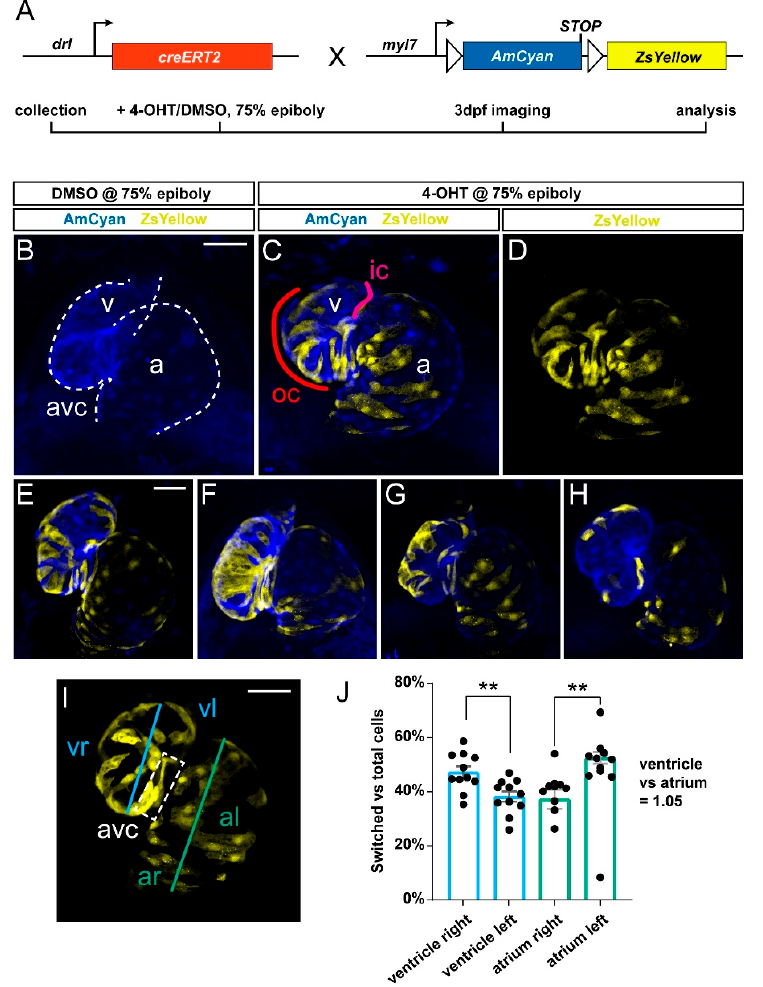
Figure 1. Predominant labeling of the first heart field (FHF)-assigned embryonic myocardium using drl:creERT2 . ( A ) Crossing scheme of used transgenes. drl:creERT2 is expressed in the gastrulation-stage lateral plate mesoderm (LPM) progenitors and becomes gradually restricted to FHF descendants in the heart, while myl7:Switch is a cardiomyocyte-specific loxP reporter line that by default marks myocardium in AmCyan (blue) and ZsYellow (yellow) upon exposure to active Cre recombinase. Timeframe of involved experimental steps outlined below. See text for details. ( B – H ) Maximum intensity projections of confocal stacks taken from three dpf zebrafish embryos double-transgenic for dr:creERT2;myl7:Switch and 4-OH-Tamoxifen (4-OHT)- or DMSO control-induced at 75% epiboly. Ventral views, rostral to the top. Channel merge shown for a DMSO control heart (( B ), note absence of ZsYellow due to absence of CreERT2 activity, n = 6) and a representative 4-OHT-treated heart together with ZsYellow lineage label only (( C , D ), n = 11), atrium (a), ventricle (v), and atrio-ventricular canal (avc), color-annotated for predominantly second heart field (SHF)-derived inner curvature (ic), predominantly FHF-derived outer curvature (oc). Additional hearts of the imaging series are shown below ( E – H ); note the distribution of drl:creERT2 -induced ZsYellow clones throughout the atrium and ventricle. ( I , J ) Quantification of clone distribution throughout atrium and ventricle, division lines for left vs. right atrium (al, ar) and ventricle (vr, vl), with boxed atrioventricular canal shown ( I ) that predominantly lies on the left side using this analysis and contributes to possible overrepresentation of left-sided clones in the ventricle. ** p = 0.002 for atrium, ** p = 0.0046 for ventricle, bar diagram depicts mean with error bars as SEM, significance based off differences was calculated using a two-tailed Student’s t -test ( n = 11 hearts). Ratio of total linage labeling in ventricle versus atrium is almost identical (1.05). Scale bars: 50 µ